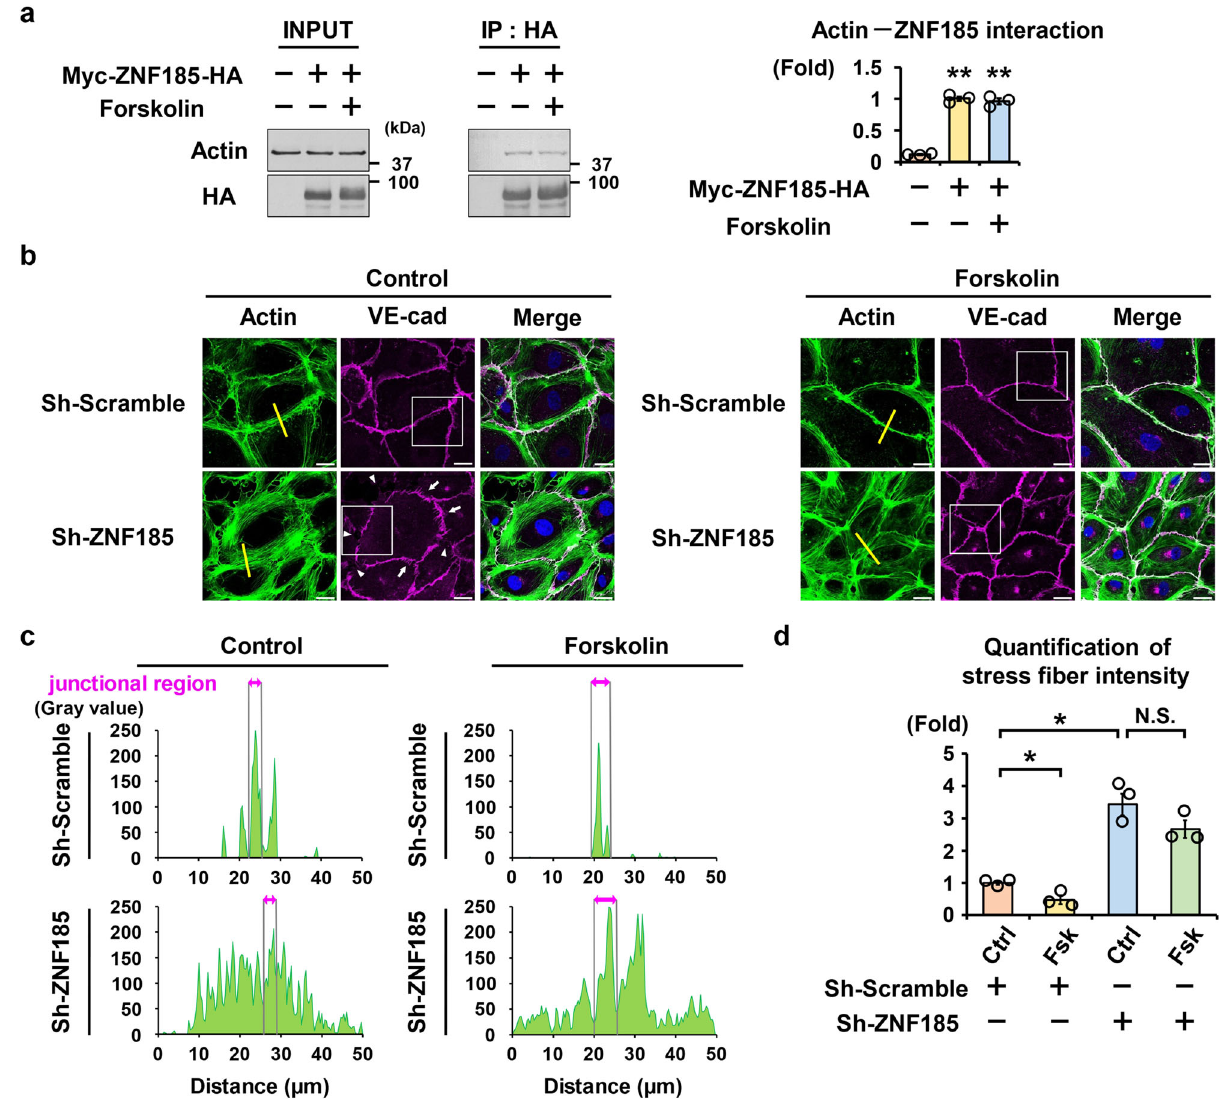
Fig. 3 ZNF185 knockdown induces stress fi ber formation. a . ZNF185 interacts with actin. Myc-ZNF185-HA was overexpressed in HUVECs. One hour after forskolin (10 µ M) treatment, HA-beads were used for coimmunoprecipitation. Representative blots are shown ( n = 3). Densitometric analysis of immunoprecipitated endogenous actin. Two-sided Student ’ s t test, ** p < 0.01 ( n = 3). b – d ZNF185 knockdown induces stress fi ber formation and indicate discontinuous zig-zag junctions. Arrowheads indicate intercellular gaps. Representative images are shown ( n = 3, Supplementary Fig. 6). Scale bars, 25 µ m. c Intensity of stress fi bers at the yellow lines in Fig. 3b was quanti fi ed. d The bar graph shows total amount of stress fi ber intensity in Fig. 3c. Two-sided Student ’ s t test, * p < 0.05 ( n = 3). Data are presented as the mean ± standard error. Ctrl control, Fsk